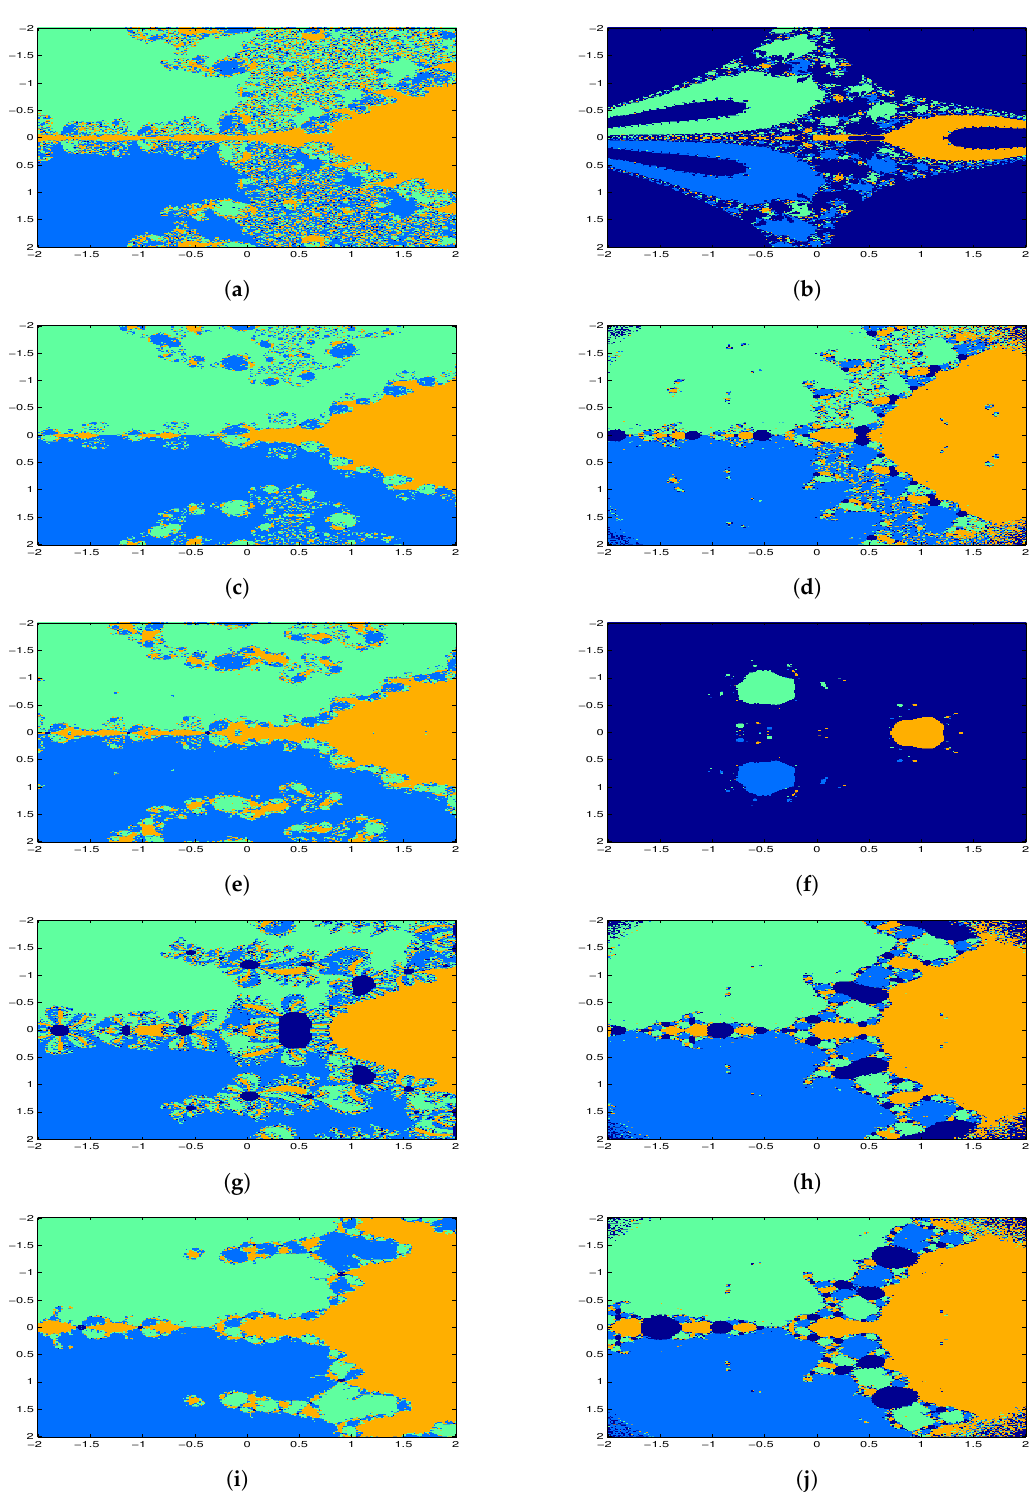
Figure 3. Polynomiographs of p 2 ( z ) : ( a ) KTM 4; ( b ) AKKB 4; ( c ) ZLM 4; ( d ) PM 4; ( e ) AKKB 8; ( f ) KBK 8; ( g ) SM 8; ( h ) PM 8; ( i ) ZLM 16; and ( j ) PM